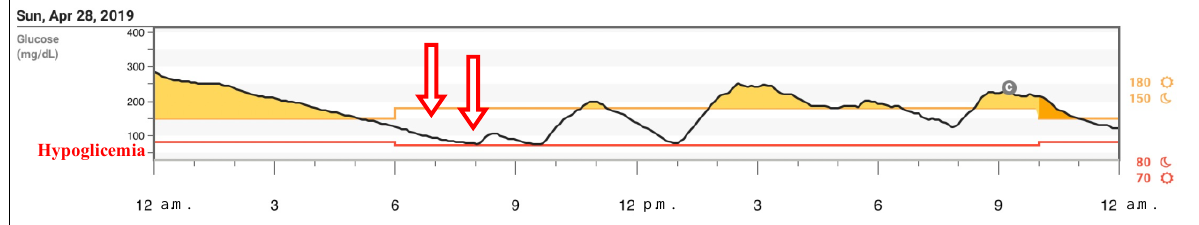
Figure 3. Glucose data reproduced from Dexcom ® CGM Clarity software (Dexcom, Inc., San Diego, CA, USA): the graph shows an example of daily glycemic excursions and evidence of hypoglycemia in the early hours of the